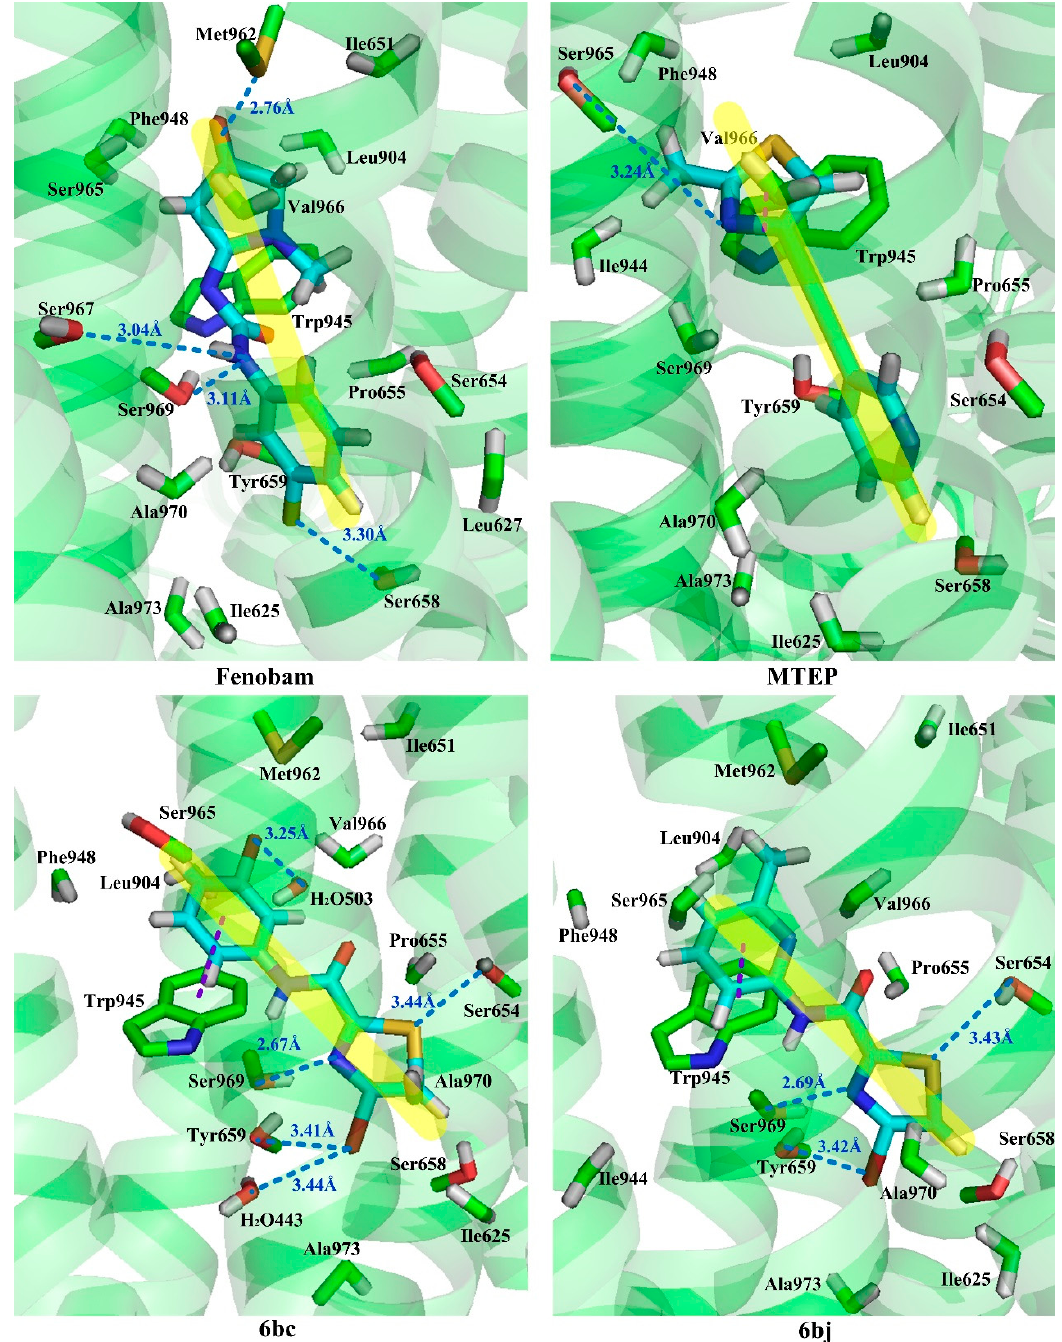
Figure 9. “Linear” binding modes of compounds Fenobam, MTEP, 6bc, and 6bj in the allosteric binding site 1 complexed with mGluR5. The H-bond and π – π stacking interactions are observed as dark blue and purple dashed lines, respectively.